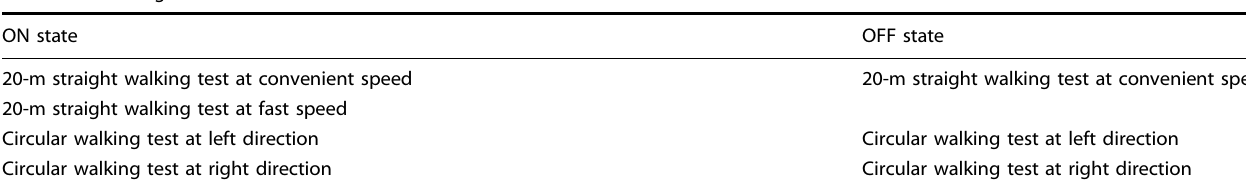
Table 3. Clinical gait